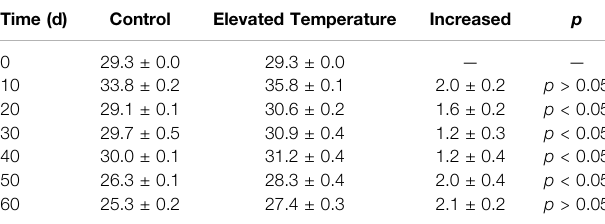
Frontiers in Environmental Science |